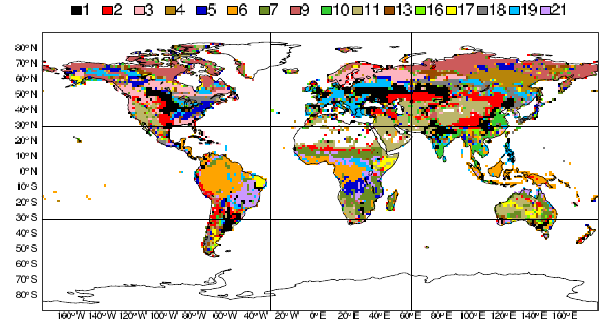
Figure 3. Dominant vegetation types based on the BATS classifica- tion used in the C-IFS and extended to include the tropical savanna subtype (in purple, as defined by the Olson (1994a) classification) within the interrupted forest type (in light blue). The vegetation type codes are described in Table 1. The nine regions used in the compu- tation of the NEE budget are delimited by the black lines.